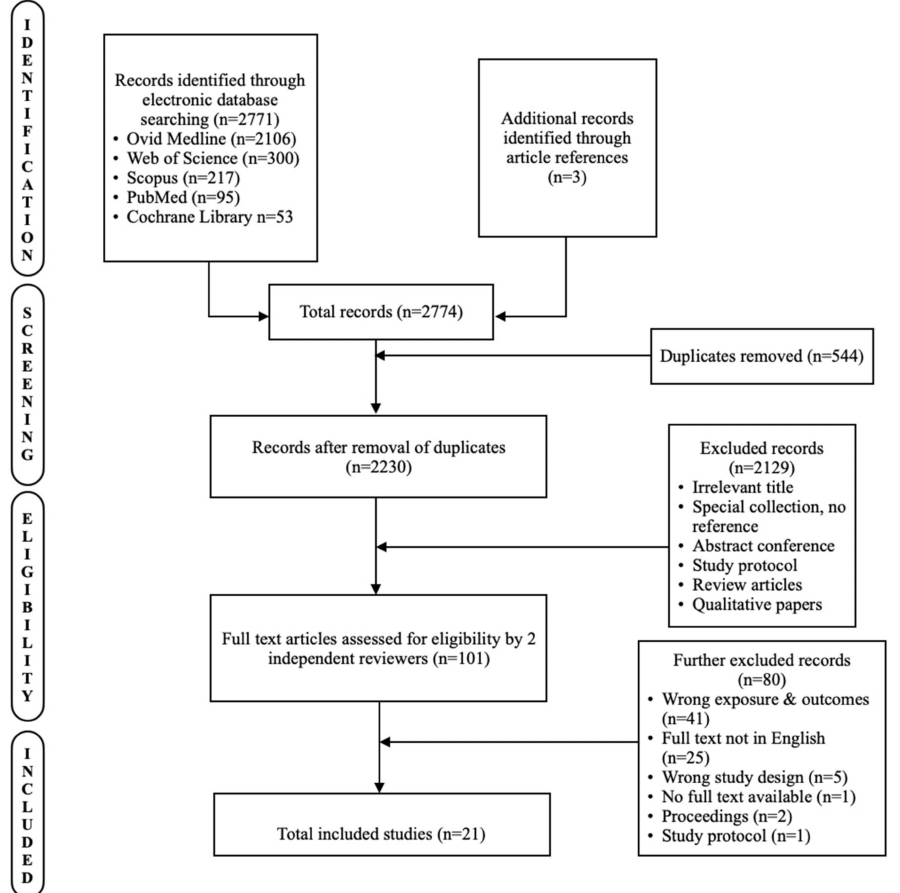
Figure 1. The PRISMA flowchart describing the flow of information through the different steps taken for this systematic